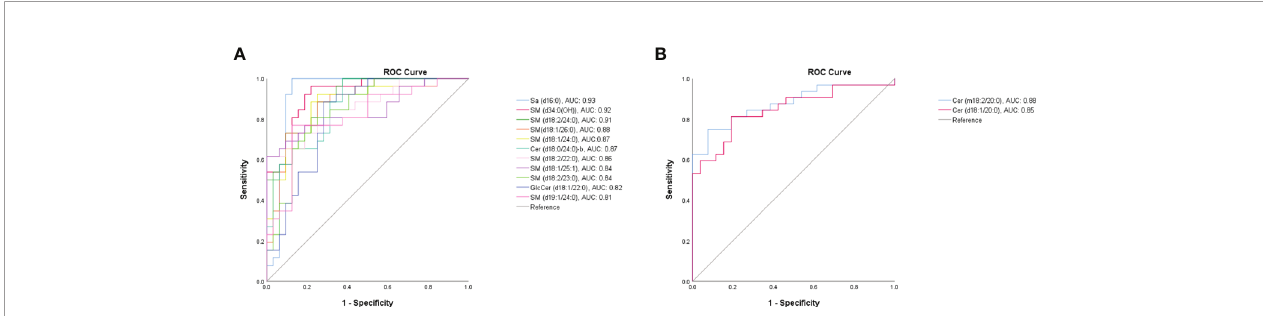
FIGURE 3 | The receiver operating characteristic (ROC) curve for SPLs with an area under the ROC curve (AUC) value > 0.80. (A) Eleven declined SPLs and (B) 2 elevated SPLs after T. marneffei infection.